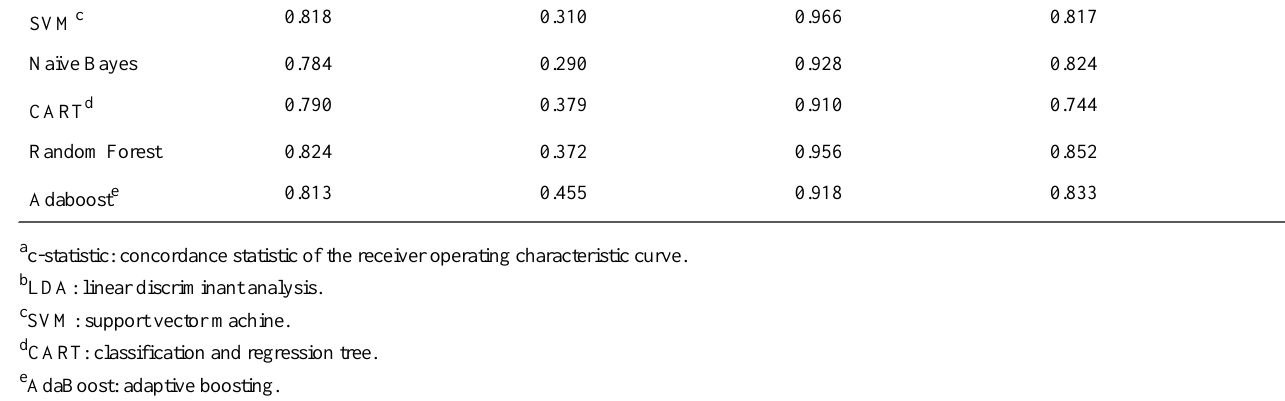
Figure 4. Receiver operating characteristic (ROC) curves with area under the curve (AUC) statistics of classification and regression tree